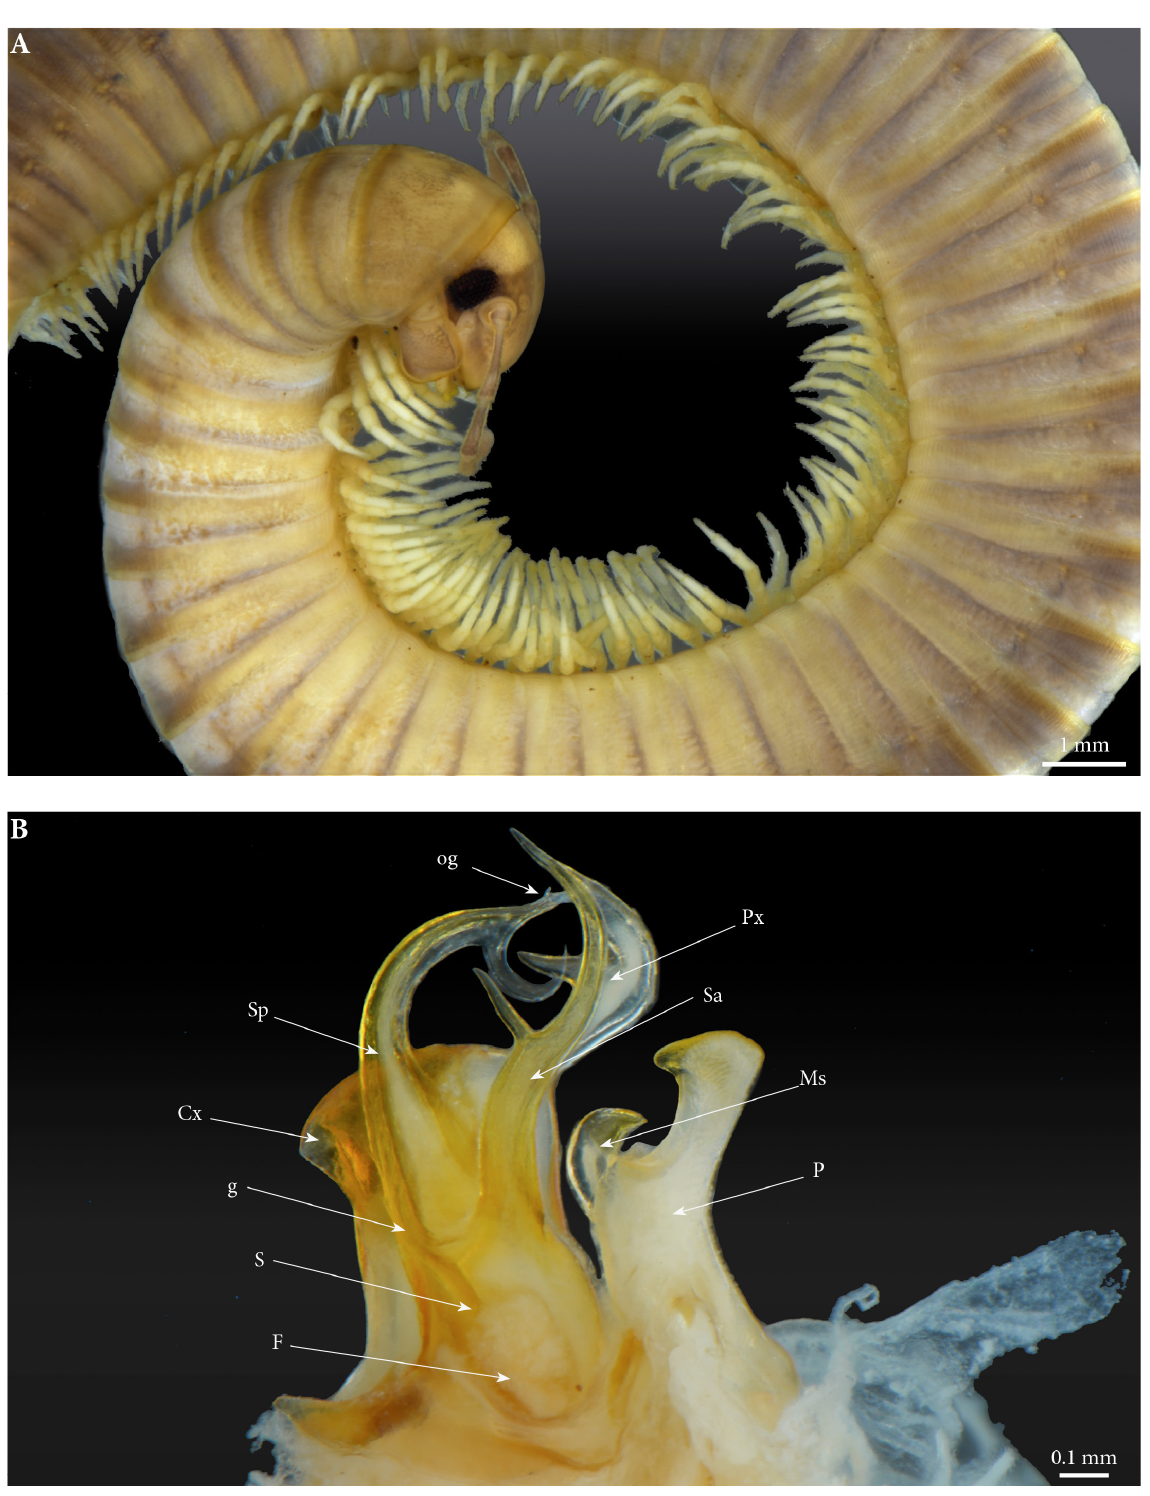
Fig. 19. Ommatoiulus staglae sp. nov. Paratype, ♂. A . Habitus, lateral view. B . Right gonopod, mesal